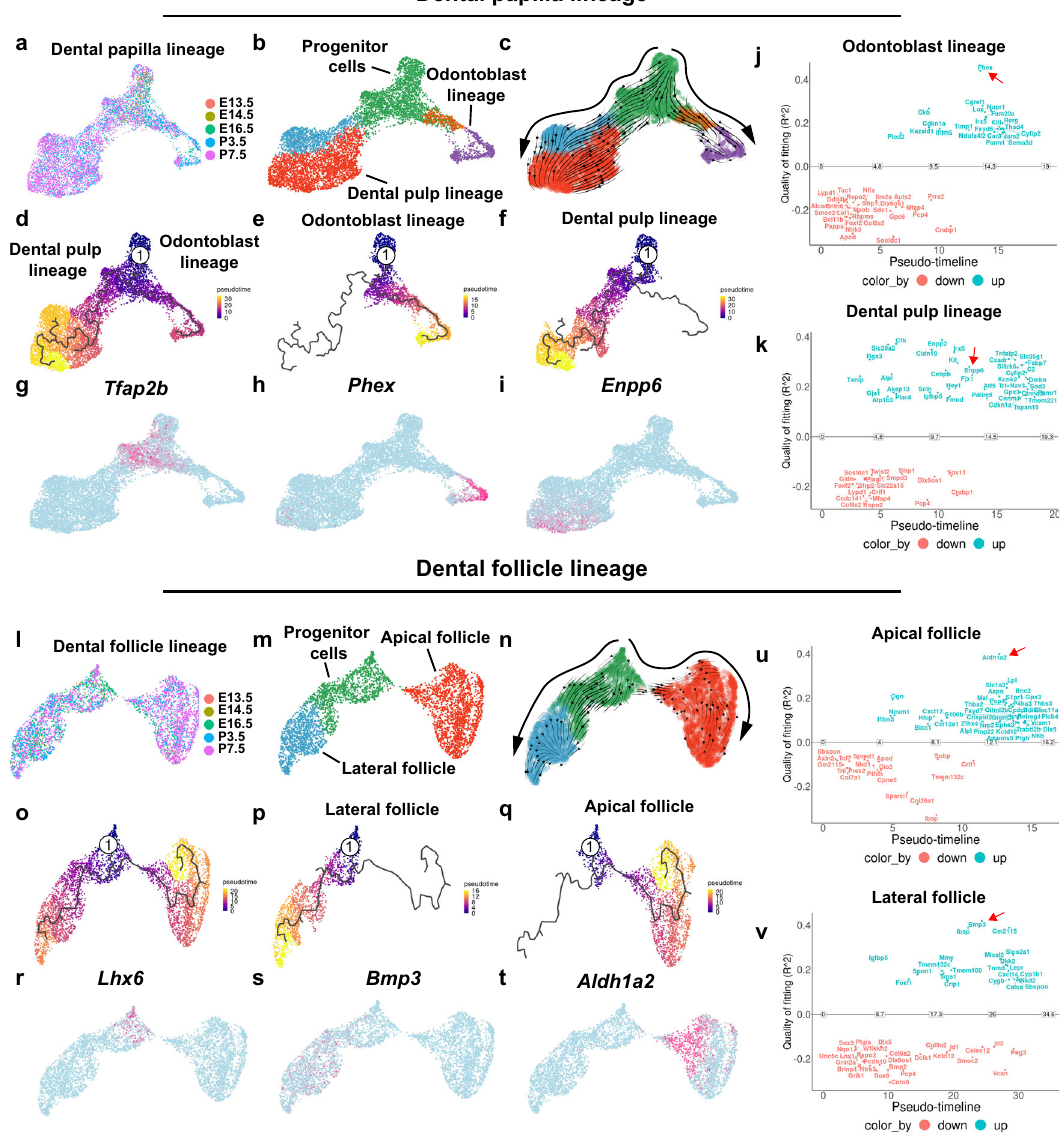
Fig. 6 | Differentiation trajectory and lineage transition in the dental mesenchyme. a Integrative analysis of the dental papilla lineage data from E13.5, E14.5. E16.5, P3.5 and P7.5. b Dental papilla clusters in integrative analysis. c DifferentiationtrajectoryinferenceofdentalpapillalineagewithVelocityanalysis. d – f Differentiation trajectory inference of dental papilla lineage with Monocle analysis. g – i Featureplotof Tfap2b , Phex and Enpp6 fromthedentalpapillalineage. j , k OdontoblastanddentalpulplineageinferencewithGeneSwitchesanalysis.Red